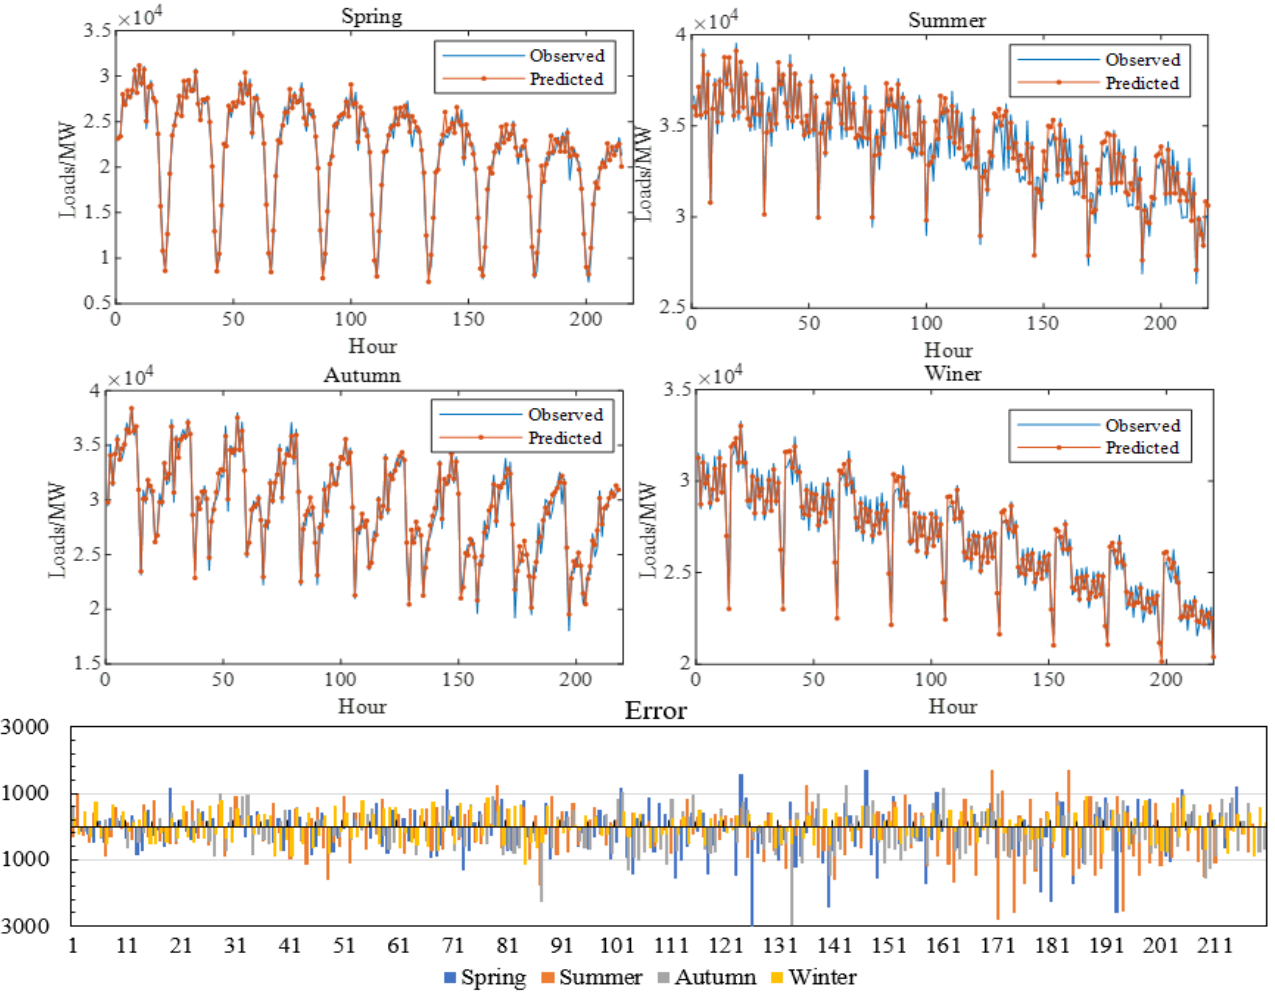
Figure 6. Experimental prediction results by season. Table 6. Prediction results of different decomposition methods (the best results of each model are